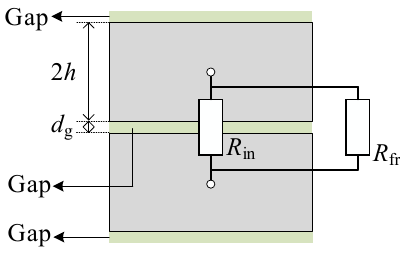
Figure 11. Simplified model of the air gap.